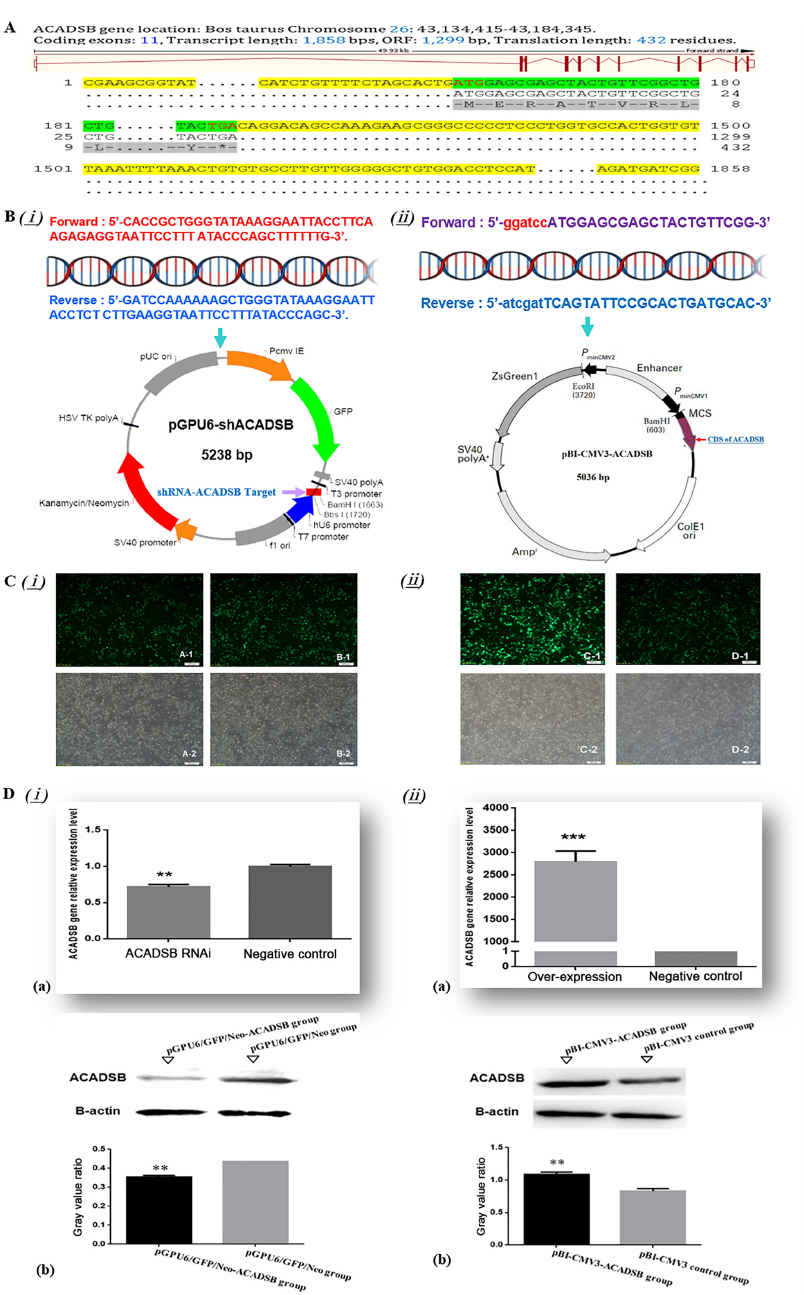
Figure 2. Construction of ACADSB gene RNA interference and overexpression vector and transfection into bovine mammary epithelial cells. (A) Bovine ACADSB gene location and structure features. (B) Primer sequence and vector of ACADSB gene. (i) Primer sequence of RNA interference target sequence and interference vector (pGPU6/GFP/Neo-ACADSB). (ii) Primer sequence of ORF and overexpression vector (pBI-CMV3-ACADSB). (C) Plasmid transfection into bovine mammary epithelial cells ( A-1 ) cells transfected with ACADSB RNAi plasmid pGPU6/GFP/Neo-ACADSB, B-1 : cells transfected with pGPU6/GFP/Neo control plasmid, C-1 : cells transfected with ACADSB overexpression plasmid pBI-CMV3-ACADSB, D-1 : cells transfected with pBI-CMV3 control vector. (D) mRNA and protein of ACADSB expression in bovine mammary epithelial cells that transfected with RNAi and overexpression plasmid. (i-a) : ACADSB mRNA expression in bMECs that transfected with RNAi plasmid; (i-b) : ACADSB protein expression in bMECs that transfected with RNAi plasmid; (ii- a) : ACADSB mRNA expression in bMECs that transfected with overexpression plasmid; (ii-b) : ACADSB protein expression in bMECs that transfected with overexpression plasmid (the protein expression level of ACADSB using gray value analyzer to calculate gray value ratios (target protein content/ β -actin